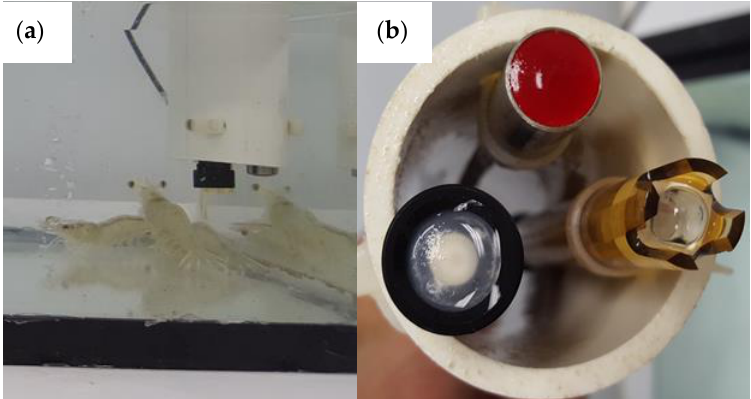
Figure 3. ( a ) PVC tube with vertical electrodes; and ( b ) underneath view of electrodes: black for dissolved oxygen, yellow for pH, and red sensor is temperature (from atlas scientific).